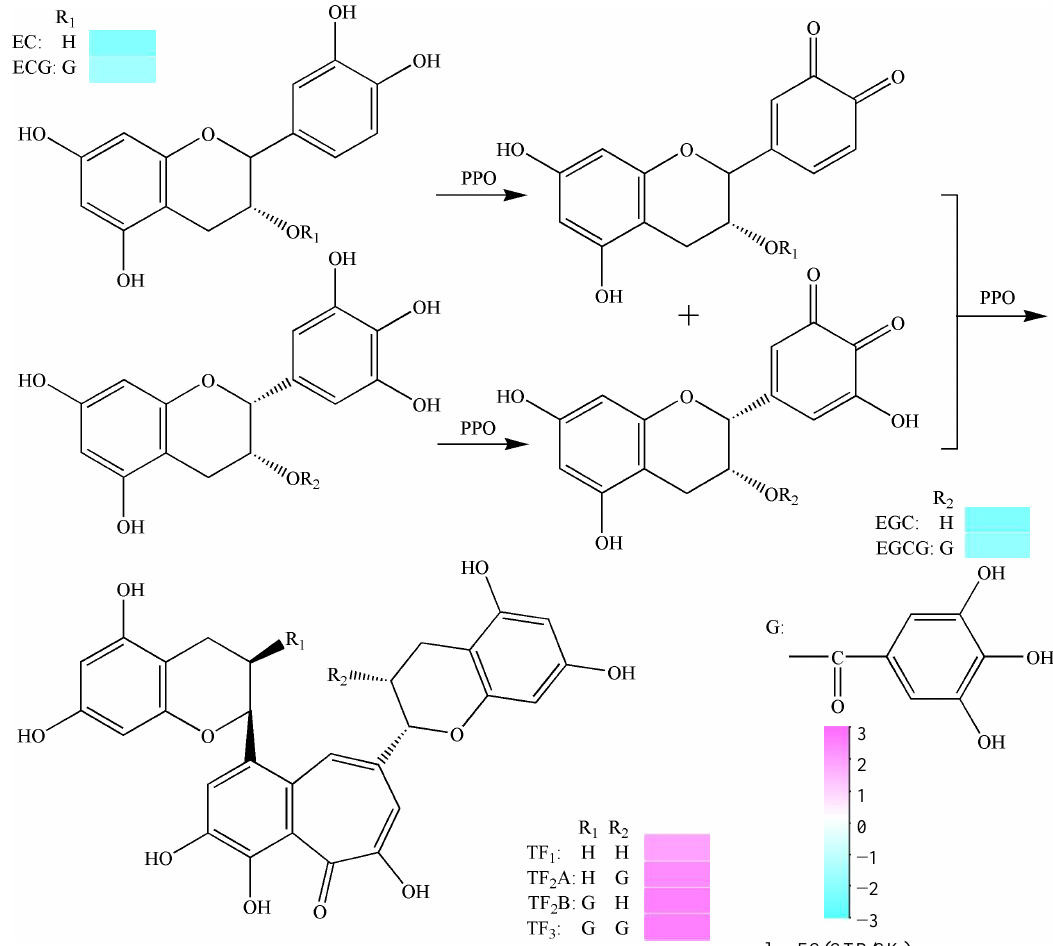
Figure 5. The change of levels and possible formation mechanism of theaflavin (TF 1 ), theaflavin-3- gallate (TF 2 A), theaflavin- 3′ -gallate (TF 2 B), and theaflavin 3, 3′ -digallate (TF 3 ) from catechins cata- lyzed by PPO.